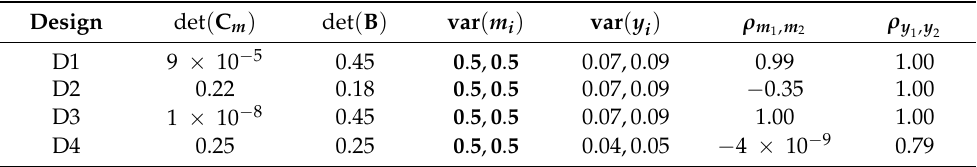
Table 9. Characterization of inputs and outputs designs D1–D4 for a 2 × 2 two-stage absorber; active constraints are in bold.